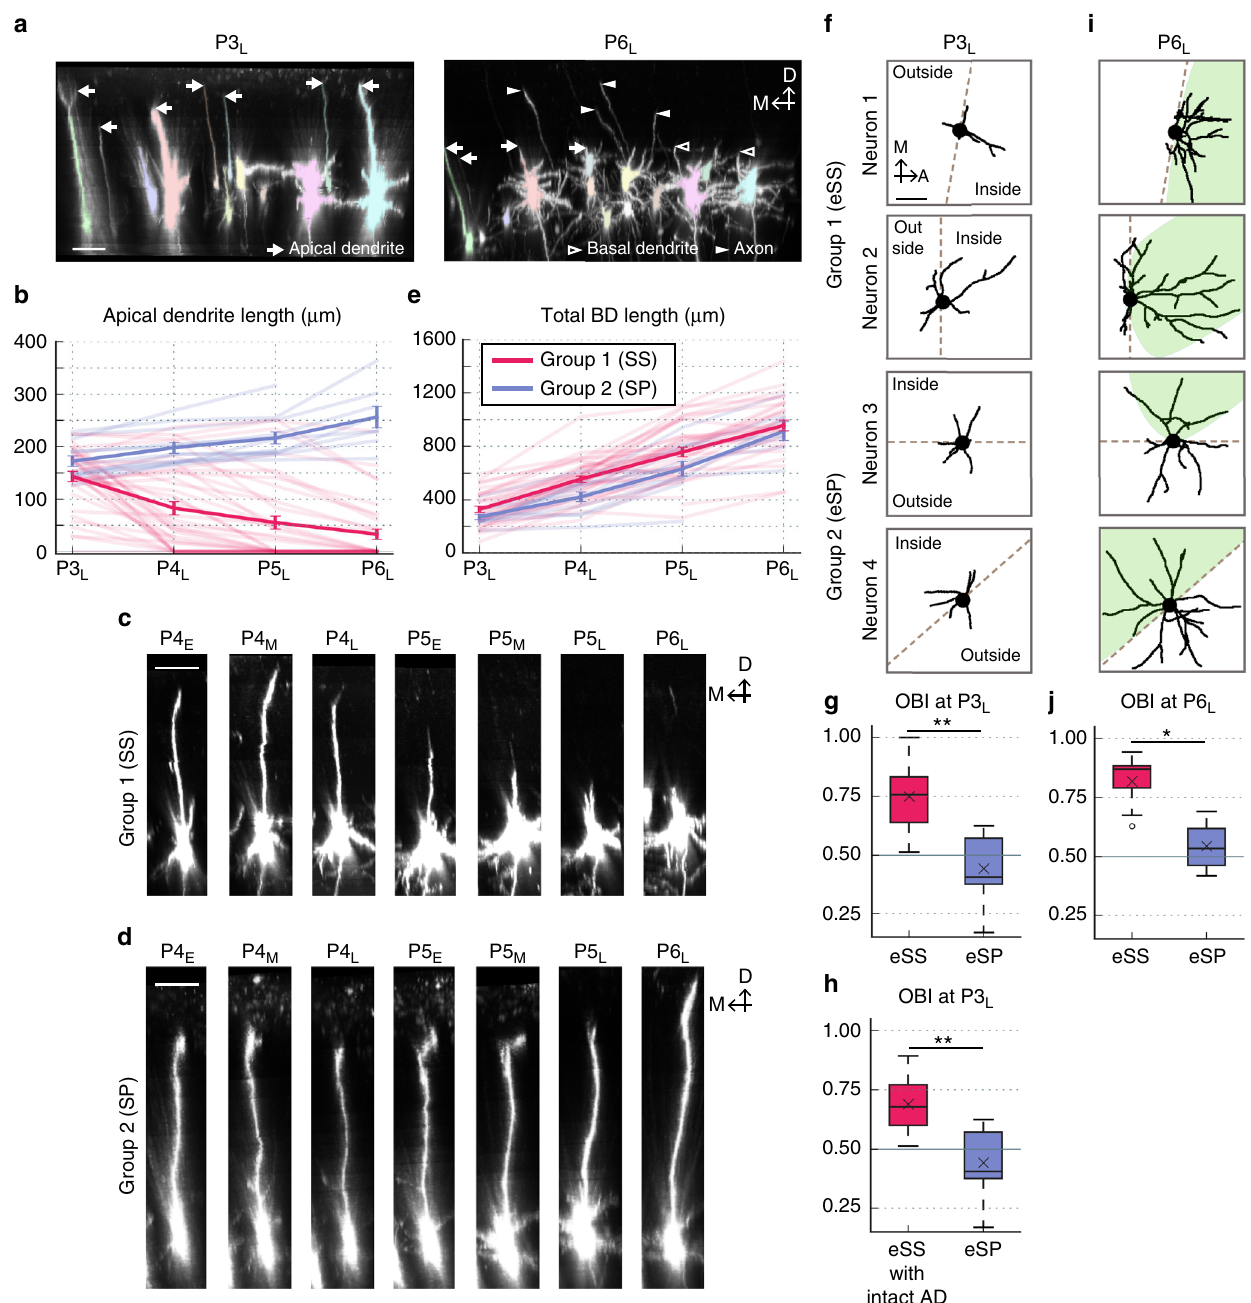
Fig. 2 AD dynamics and morphological features of L4 neurons in early neonates. a Most L4 neurons possessed an AD at P3 L , while the majority of these neurons had shortened ADs by P6 L . The same neurons are colored the same. Arrows, AD tips; fi lled arrowheads, axons; open arrowheads, BD tips. M medial, D dorsal. b Plots of the mean ± SEM (dense) and individual (faint) of AD length of Group 1 (red) and Group 2 (blue) neurons (see also Supplementary Fig. 2). c , d Examples of AD dynamics in Group 1 ( c ) and Group 2 ( d ) neurons. D dorsal. e The mean ± SEM (dense) and individual (faint) plots of total BD length of Group 1 (red) and Group 2 (blue) neurons. Sample sizes for b and e are shown in the Methods. f Representative BD traces of two Group 1 (SS) and two Group 2 (SP) neurons at P3 L . The boundaries of inside (barrel-center side) and outside (opposite side) were determined as described in Supplementary Fig. 1d and Methods. g The orientation bias index (OBI) of barrel-edge SS (eSS) neurons was signi fi cantly larger than that of barrel-edge SP (eSP) neurons at P3 L ( p = 0.001, g = 2.135, Welch ’ s t -test: n = 15 eSS neurons from 7 mice and 7 eSP neurons from 4 mice). h Even before the initiation of AD retraction, eSS neurons already exhibited a larger OBI than eSP neurons ( p = 0.007, g = 1.710, Welch ’ s t -test: n = 8 eSS neurons with intact AD from 6 mice and 7 eSP neurons from 4 mice). i BD traces at P6 L of the same neurons as Fig. 2f. Green shades represent individual barrels (TCA clusters). j The OBI of eSS neurons was signi fi cantly larger than that of eSP neurons at P6 L ( p = 0.012, g = 2.604, Welch ’ s t -test: n = 13 eSS neurons from 5 mice and 4 eSP neurons from 2 mice). Box plot interpretation is described in the Methods. Scale bars: 50 µ m ( a , c , d ) and 25 µ m ( f